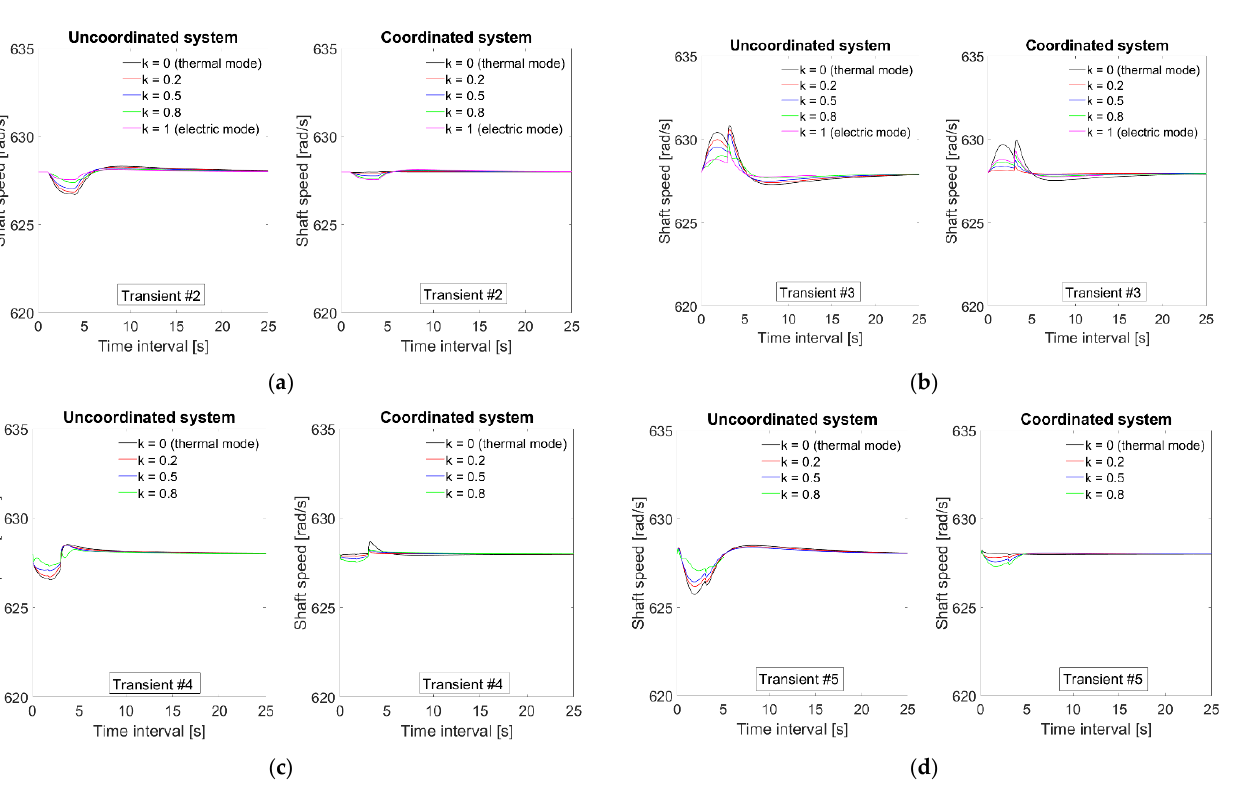
Figure 7. Torque required by rotor shaft (vertical dashed lines correspond to transient start and end).